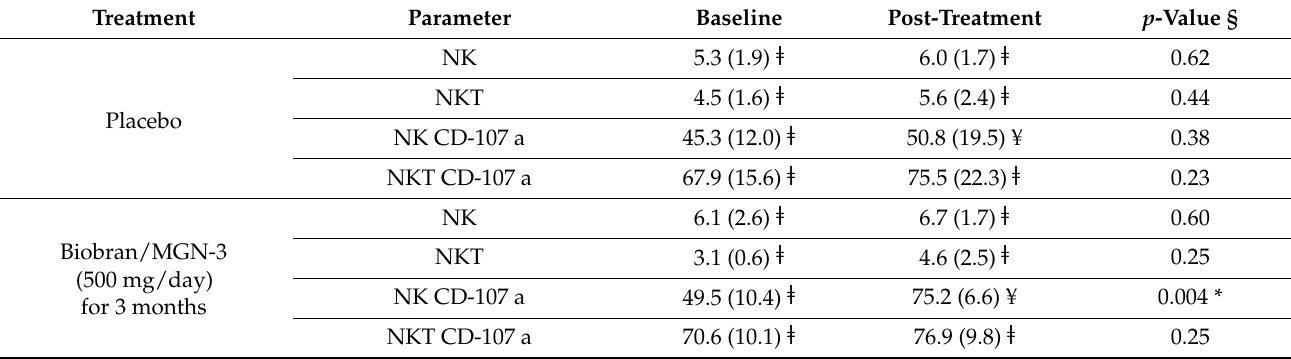
Table 2. Comparison of NK, NKT, and CD-107a-expressing NK and NKT cells within groups (before and after treatment) and between groups (Biobran/MGN-3 and placebo groups).